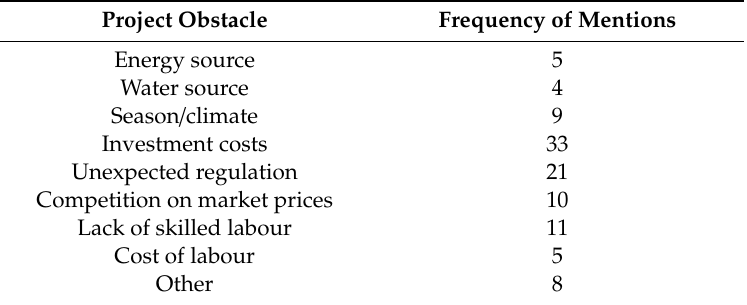
Table 6. Main challenges of commercial aquaponics as perceived by the French responders (N = 43). Answers to the question: Relating to the project’s life cycle, what main di ffi culties have you encountered? Several answers were possible.